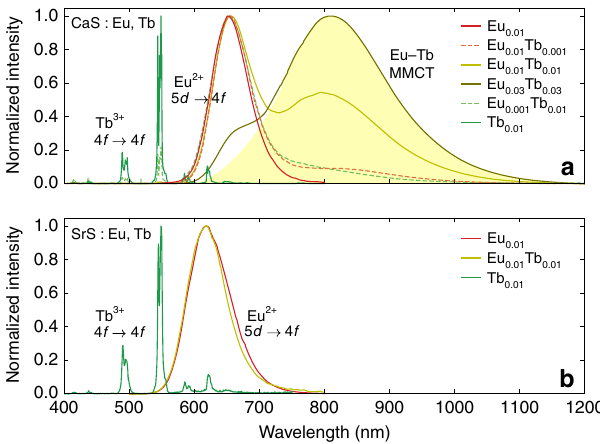
Fig. 1 Photoluminescence emission spectra. Photoluminescence emission spectra of Eu 2 + - and Tb 3 + -codoped CaS ( a ) and SrS ( b ) phosphors. The spectra were collected upon 285 nm excitation for the Eu- and Eu/Tb- codoped powders and upon 305 nm excitation for the Tb-doped powders. The spectral shape of the infrared metal-to-metal charge transfer (MMCT) emission is highlighted in yellow as a guide to the eye. All spectra were measured at room